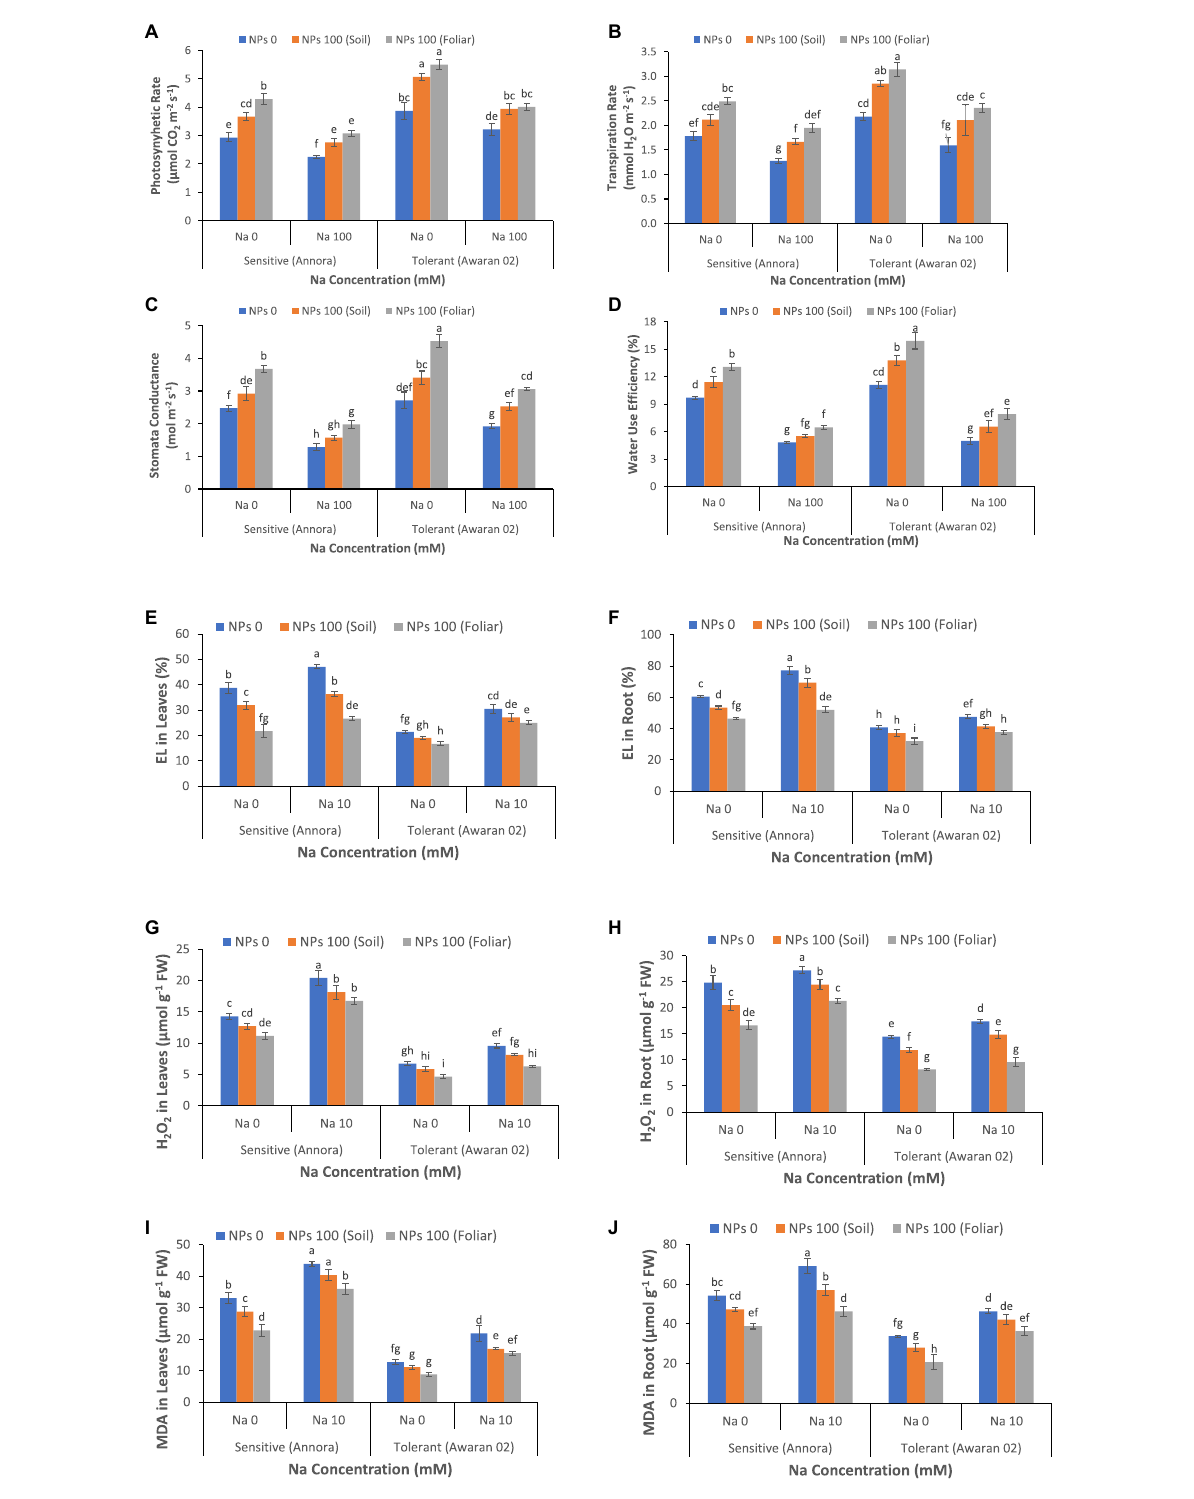
FIGURE3 Effects of different concentrations of NaCl (0 and 100 mM) and ZnO NPs (0, 100 mg kg − 1 soil, and 100 mg L − 1 foliar) on (A) net photosynthesis rate, (B) transpiration rate, (C) stomatal conductance, (D) water use efficiency, (E) EL in leaves, (F) EL in roots, (G) H 2 O 2 in leaves, (H) H 2 O 2 in roots, (I) MDA in leaves, and (J) MDA in roots of two barley genotypes Annora (salt sensitive) and Awaran 02 (salt tolerant). Values are expressed as means of three replicates with standard deviations. Different letters indicate that the values are significantly different at a p -value <